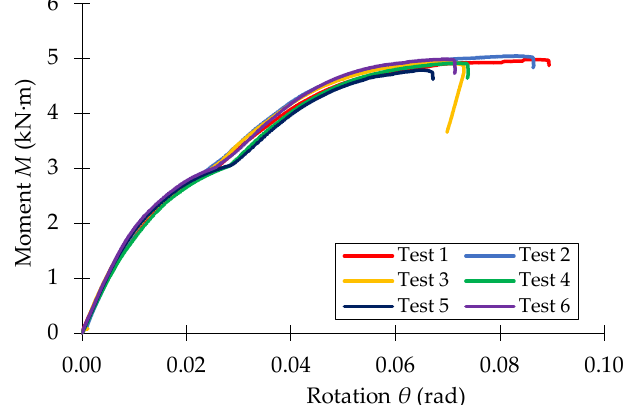
Figure 12. Moment-rotation curve ( M − θ ) recorded in bending tests for the beam-connector-upright assembly of type 0-III-5T.